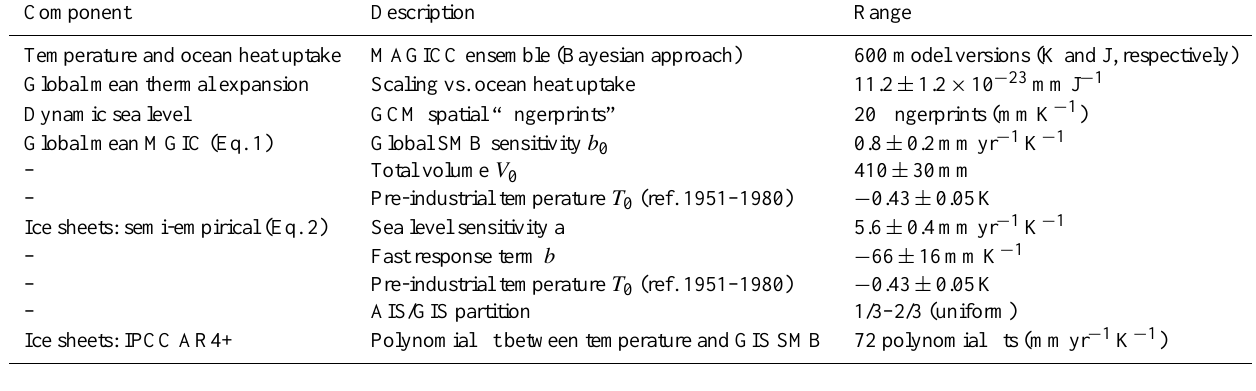
Table 2. Summary of uncertainty components accounted for in the Monte Carlo scheme. All uncertainties are combined using Monte Carlo sampling of the parameter distributions and model ensembles (10000 samples). When not indicated otherwise, the ranges indicate ± 1s.d.; SMB stands for surface mass balance.